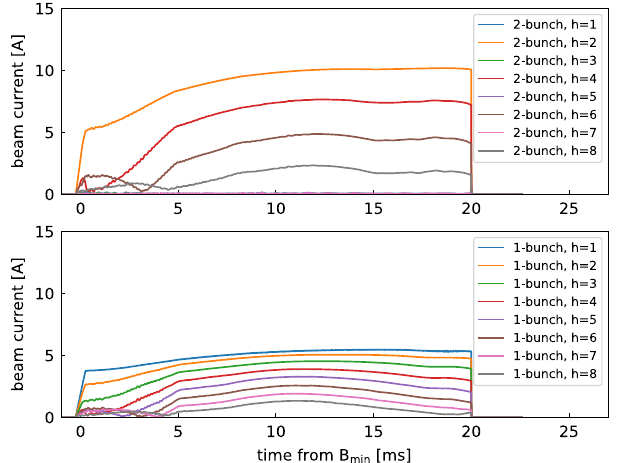
FIG. 28. Harmonic components of the beam current in the cases of (top) acceleration of two bunches at 4 . 2 × 10 13 ppp and (bottom) acceleration of a single bunch at 2 . 1 × 10 13 ppp.